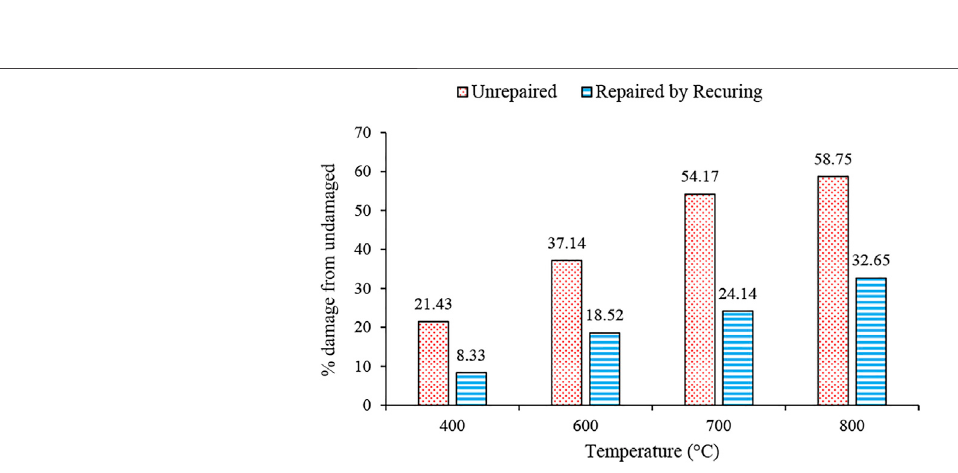
FIGURE 8 | Percentage damage and repair by re-curing using ultrasonic pulse velocity